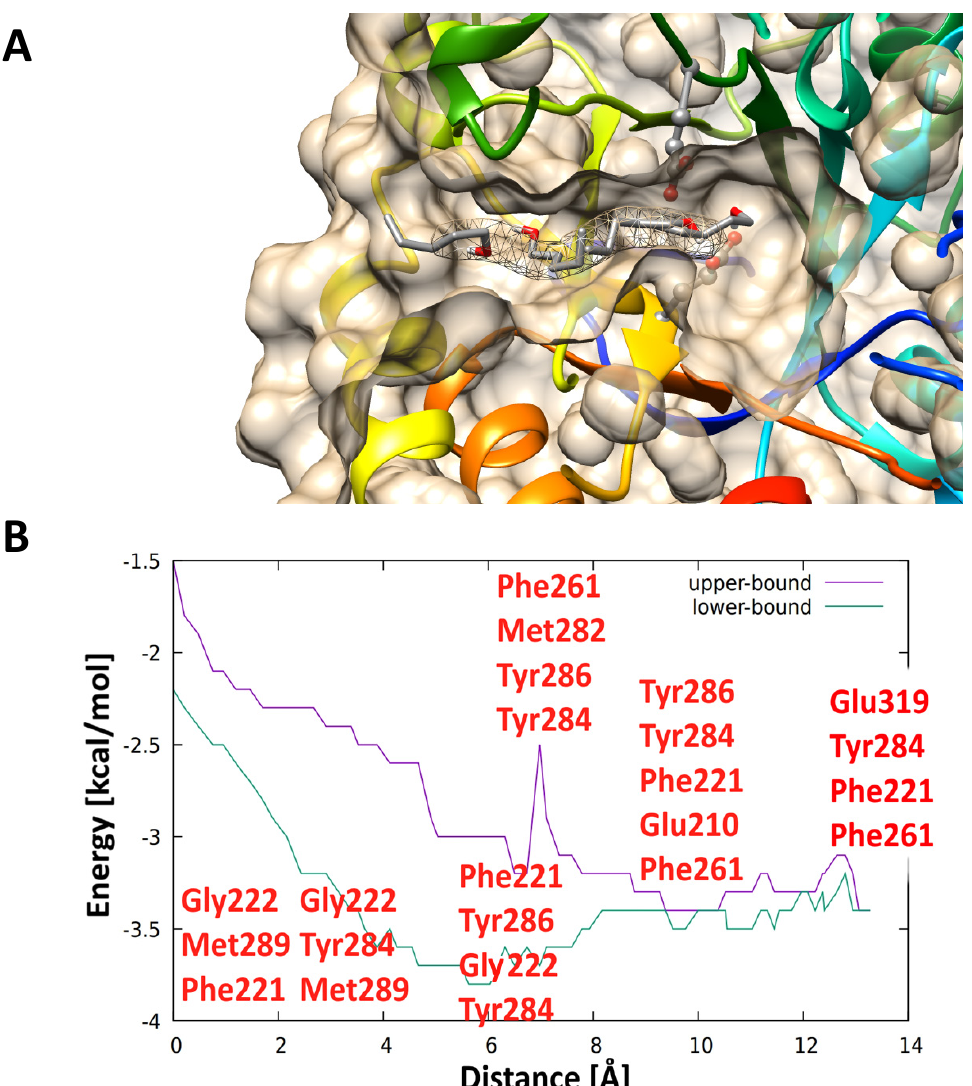
Figure 7. ( A ) Selected snapshots of aliphatic acceptor (pentanol, 3 ), passing through the second tunnel to the active site of An Rut protein; ( B ) binding energy profile of acceptor 3 passing through the side tunnel. During the acceptor passage through the side tunnel, the non-covalent interactions of amino acid residues (indicated in red in panel ( B )) with acceptor 3 were recorded.